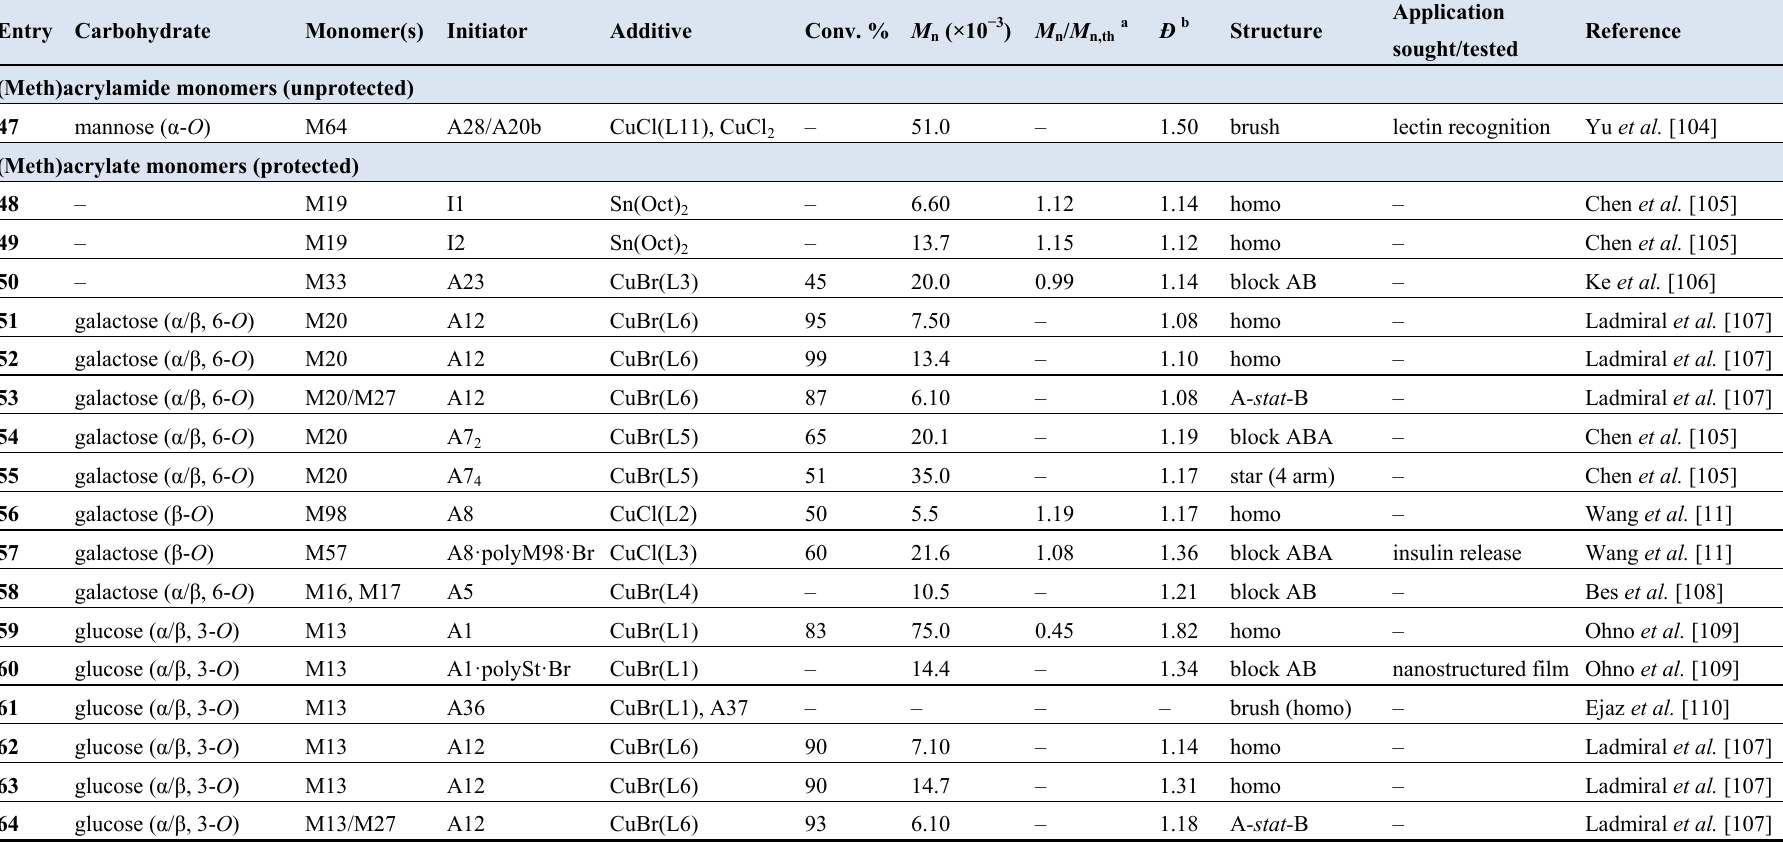
Table 2. Glycopolymers by Atom Transfer Radical Polymerization